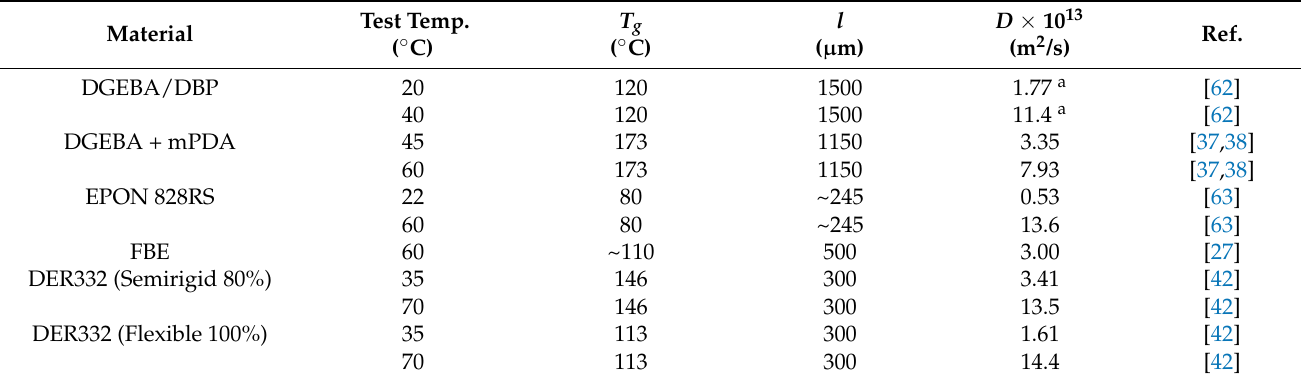
Table 1. Water vapor diffusion coefficients in different epoxy compositions based on gravimetric uptake measurements. Test Temp. Material ( ◦